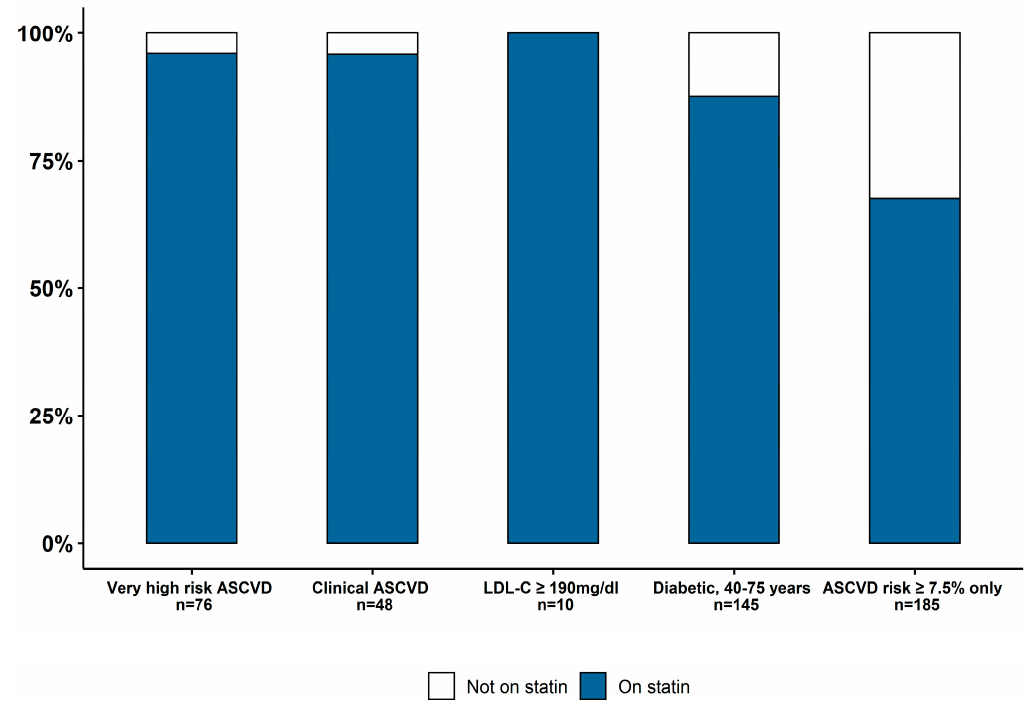
Figure 2. Rate of statin prescription and underprescription based on statin eligibility group per 2018 AHA/ACC guidelines.